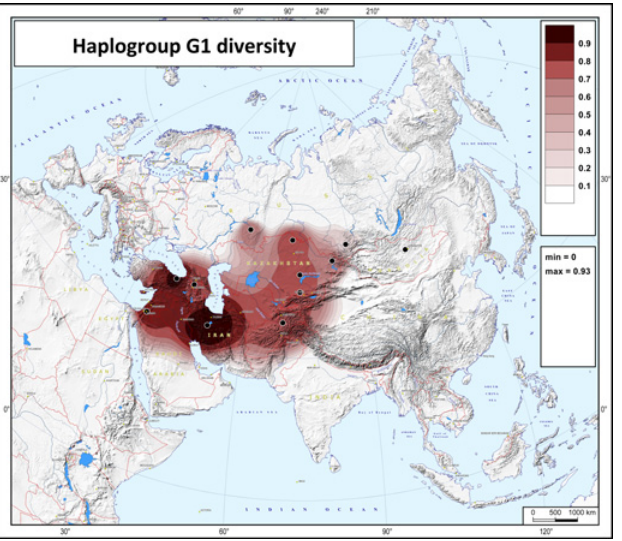
Fig 4. Map of haplotype diversity of haplogroup G1. The black points represent the populations for which diversity values were calculated. Abbreviations in the statistical legend indicate the following: MIN and MAX, the minimal and maximum values on the